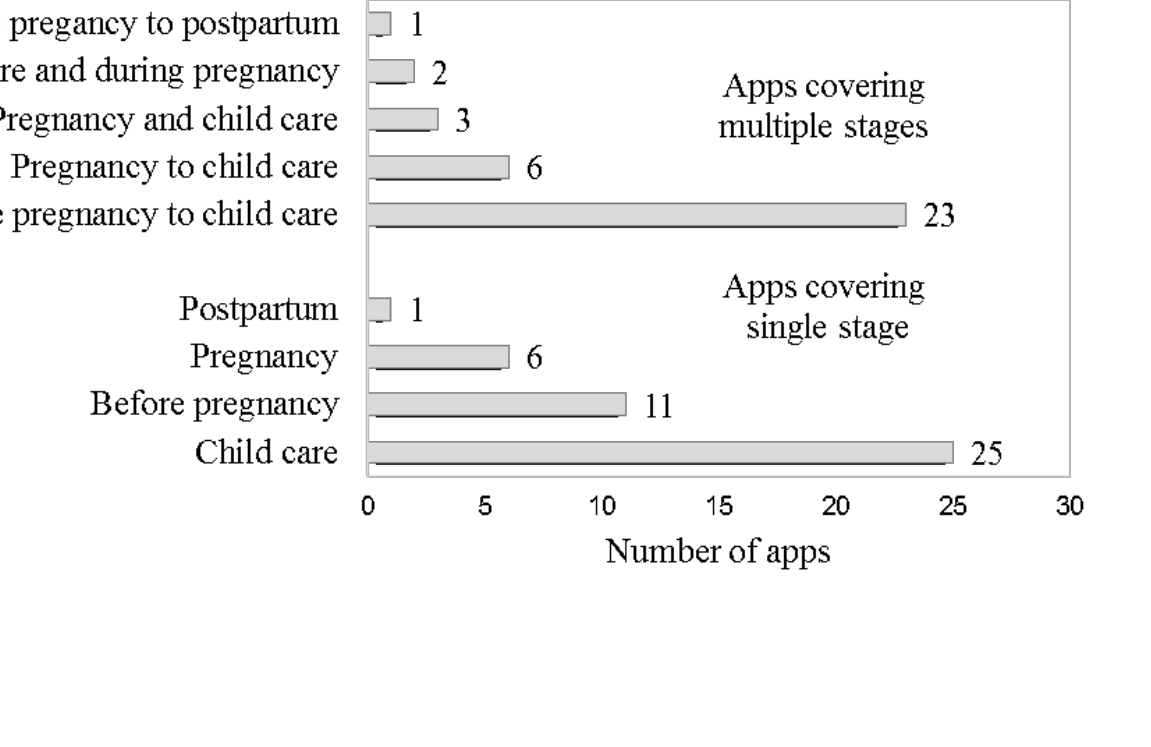
Figure 2. Stages of maternal and child health care covered by the 78 most popular